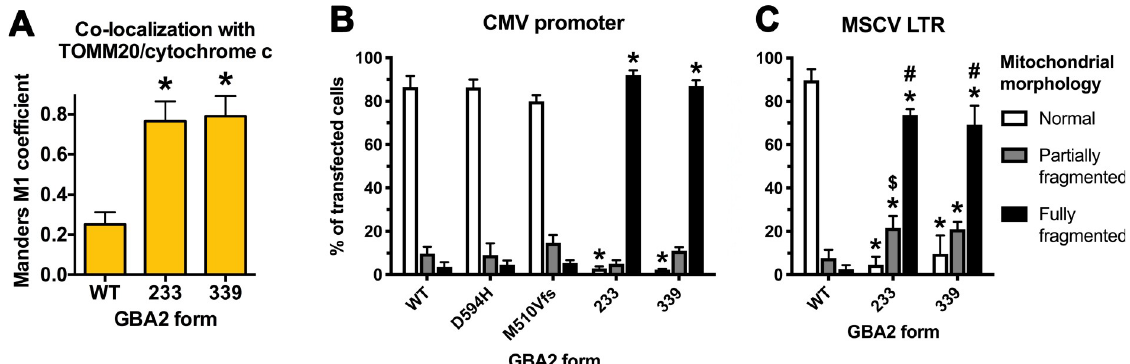
Fig 4. Truncated GBA2 mutants co-localize with mitochondria and induce mitochondrial fragmentation. (A) Colocalization of various forms of GBA2 with mitochondrial markers TOMM20 or cytochrome c, expressed as the Manders M1 coefficient (data indicate means + SD; n = 3; 10 cells were analyzed per experiment). (B and C) Distribution of mitochondrial morphologies among cells expressing various forms of GBA2 under the control of (B) the CMV promoter and (C) the MSCV LTR. Data indicate means + SD; at least 250 cells were scored in each of three independent experiments. Statistical comparisons between GBA2-WT and GBA2 mutants by (A) one- or (B and C) two-way ANOVA: � , P < 0.0001. Statistical comparisons between the same forms of GBA2 expressed under different promoters (CMV v MSCV): $, P = 0.0002; #, P <